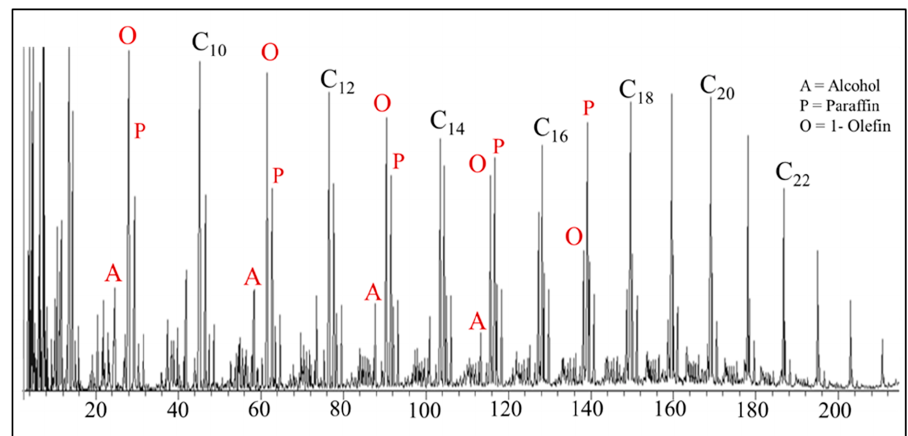
Figure 15. A chromatographic picture of the oil for the alumina supported ruthenium catalyst. The x- axis is retention time in minutes. Reaction Conditions: 241 °C, 19.2 bar, WHSV = 1.5, and H 2 /CO = 2.